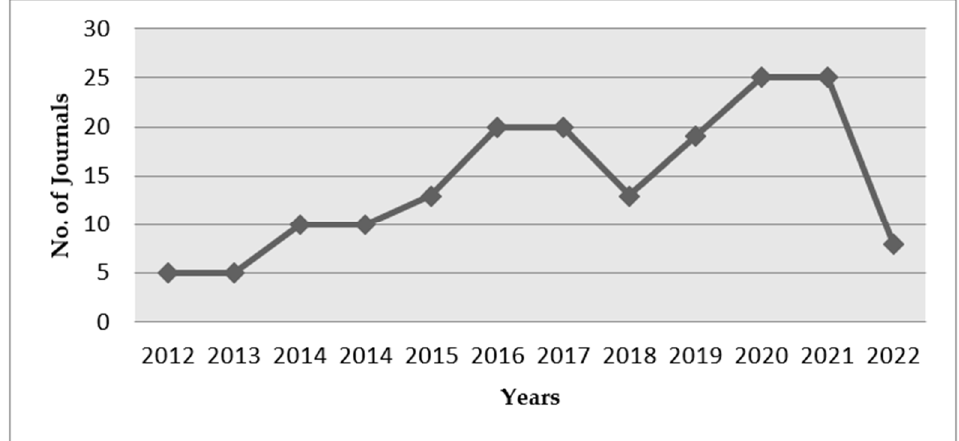
Figure 2. Past literature works (Scopus Indexed) published on self-sensing.